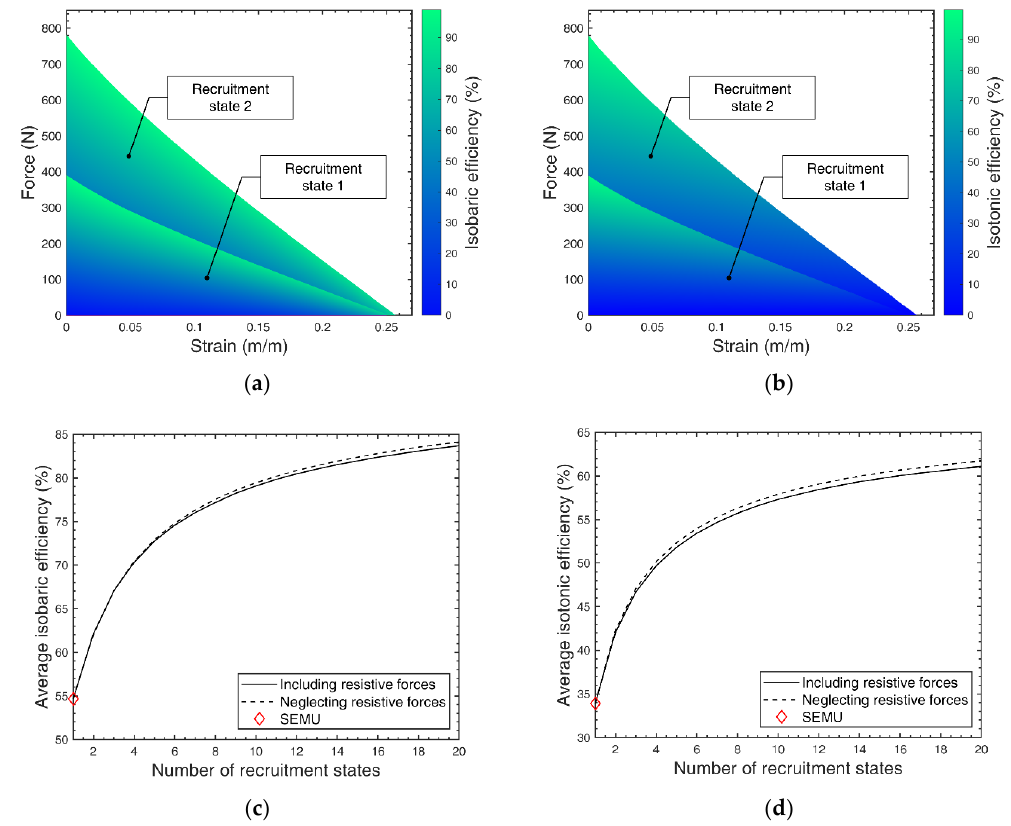
Figure 10. The efficiency of the bundle to arrive at a point in the force–strain space for ( a ) isobaric and ( b ) isotonic contractions. For isobaric contraction, the bundle is operated along the constant pressure curves, thus the force varies while contracting. For isotonic contraction, the load is held constant while the bundle contracts, thus moving horizontally within the force–strain space by varying pressure. The average isotonic and isobaric efficiencies are plotted versus number of recruitment states and shown in ( c , d ), respectively. The efficiency for a single equivalent motor unit (SEMU) is indicated as well.